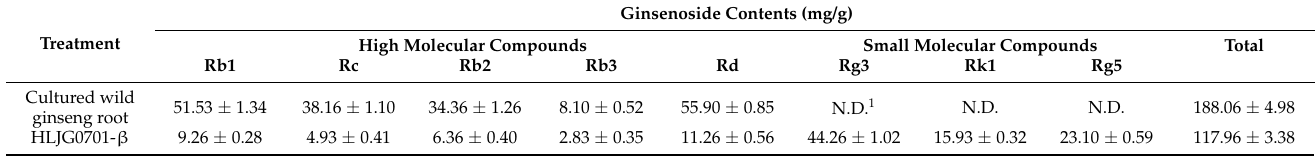
Ginsenoside Contents